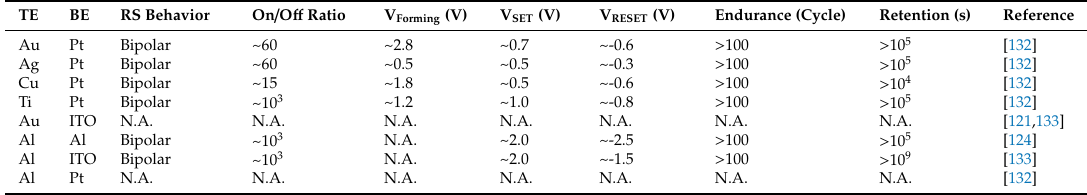
Table 4. Comparison among GO-based RRAM devices with various electrodes [121,124,132,133]. TE